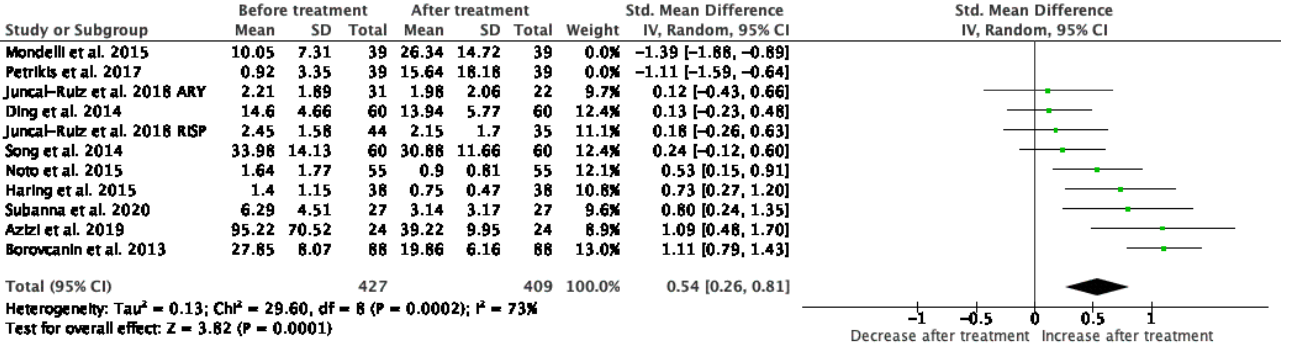
Figure 8. Meta-analysis of IL-6.